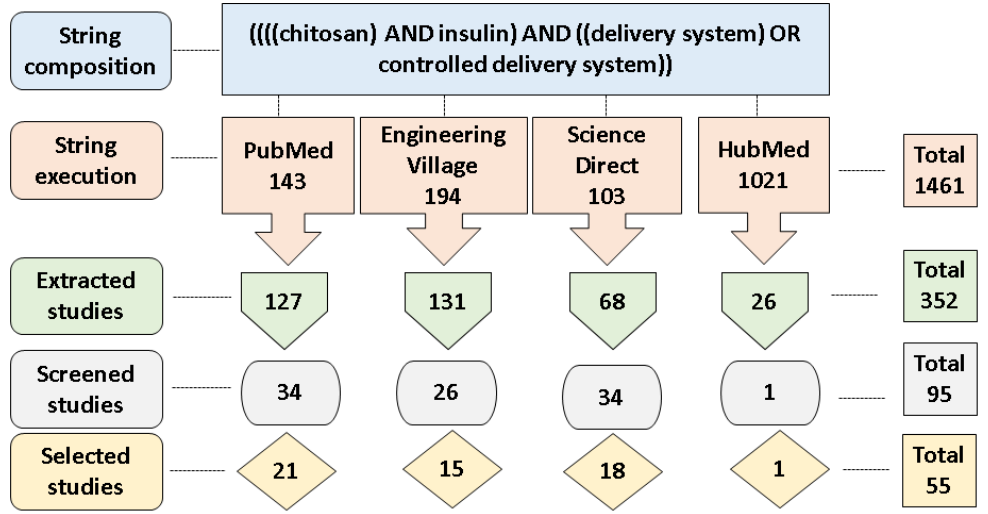
Figure 2. Scheme of the literature search process to obtain the articles used in the SR.